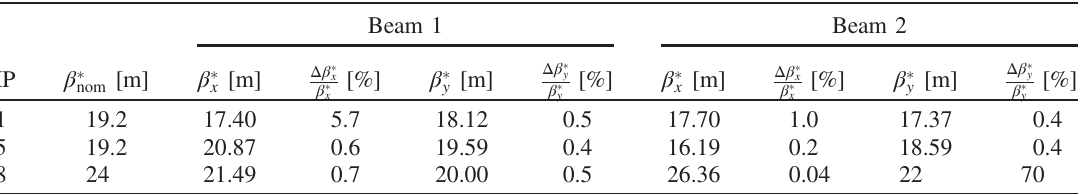
TABLE VI. Measured β (cid:1) and its associated error in IP1, IP5, and IP8 using K mod during the 2016 MD on vdM optics after introducing the IR phase advance as a constraint with Ω ¼ 0